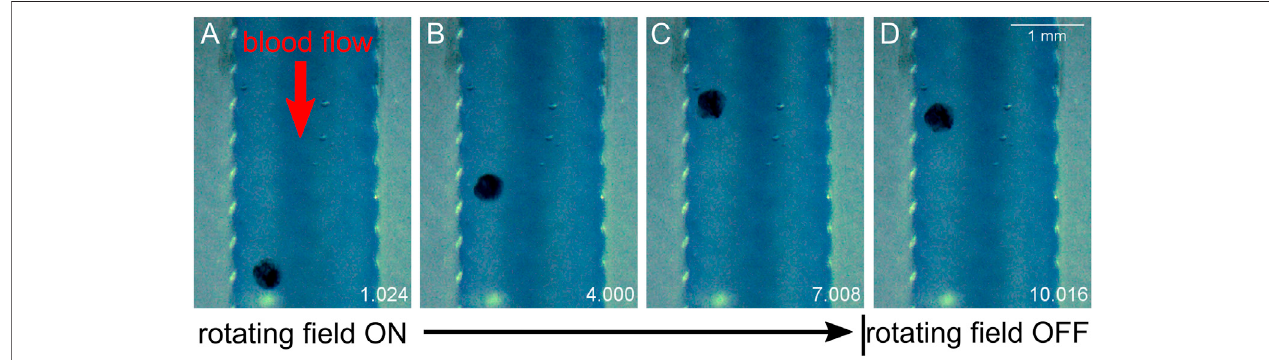
FIGURE 6 | Translation against fl ow. MANiAC moving against 160 ml/h fl ow in 10% whole mouse blood. Time is listed in the lower right of each frame in units of seconds. (A) Applied 5 Hz rotating magnetic fi eld is initiated, and (B) MANiAC begins to move against the fl ow of blood. (C) Rotating magnetic fi eld is turned off and (D) MANiACs begins to move in the direction of blood fl ow. Video frames are separated by 3 s. Video included in Supplementary Information .